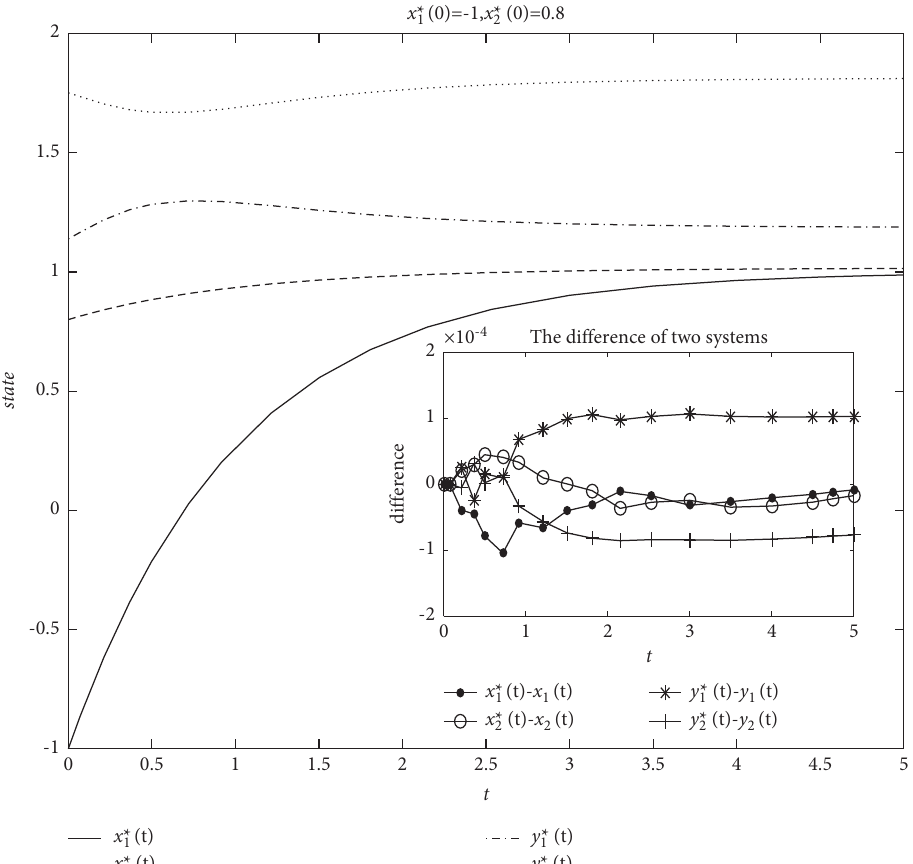
Figure 2: States ( x